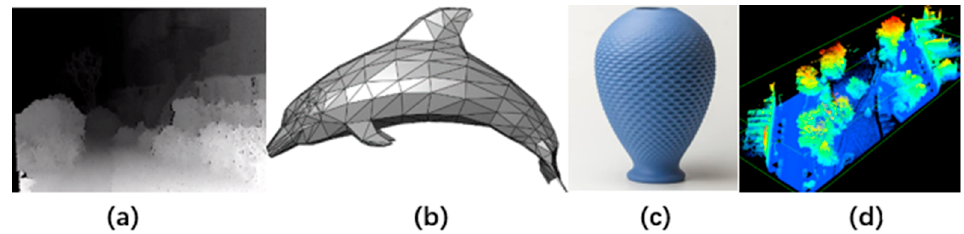
Figure 5. Data type: ( a ) depth maps, ( b ) polygon meshes, ( c ) voxels, and ( d ) 3D point clouds.